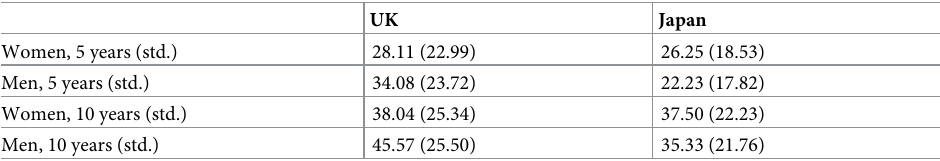
Table 3. Female and male experts’ average predictions by country (% of time